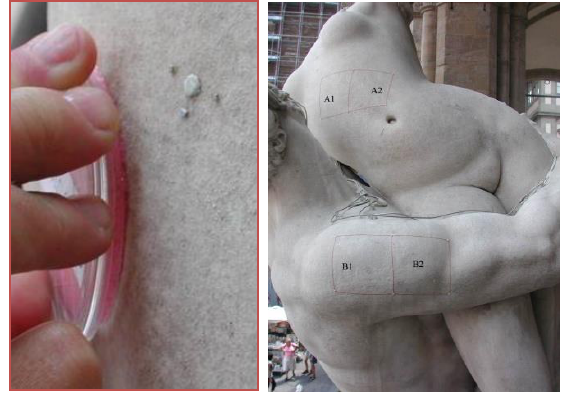
Figure 10. Contact sponge applied on a testing areas for the evaluation of water repellency of the protective treatments applied on the Marble statue of Ratto delle Sabine, Loggia dei